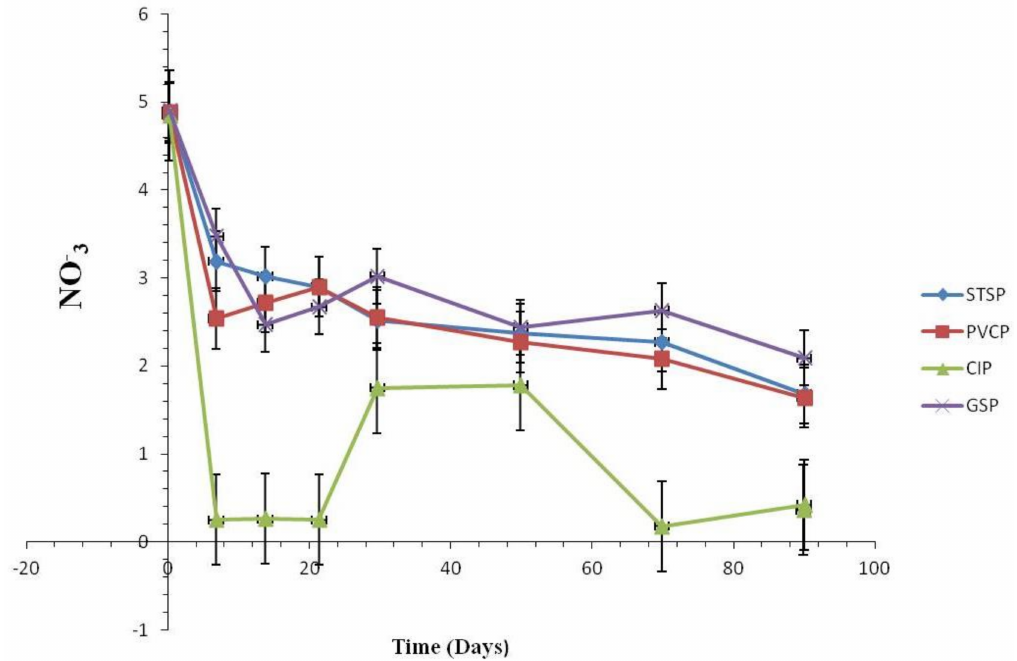
Figure 5. Variations of nitrate concentration in RW in stainless steel, polyvinyl chloride, cast iron, and galvanized steel pipes over time with standard error